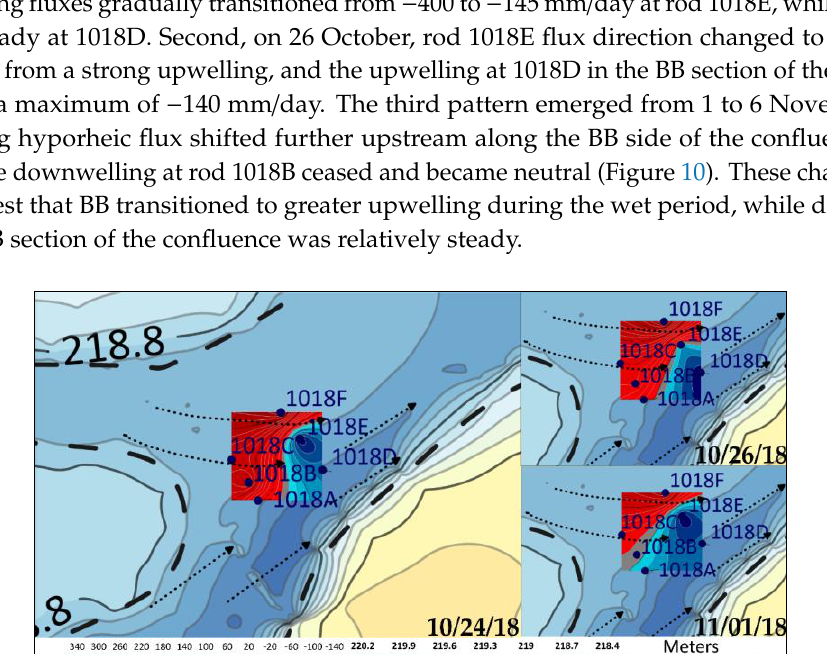
Figure 10. Vertical hyporheic fluxes (mm / day) for 23 October to 6 November 2018, derived from temperature profiles. The light blue contour represents an interpolated transitional zone.